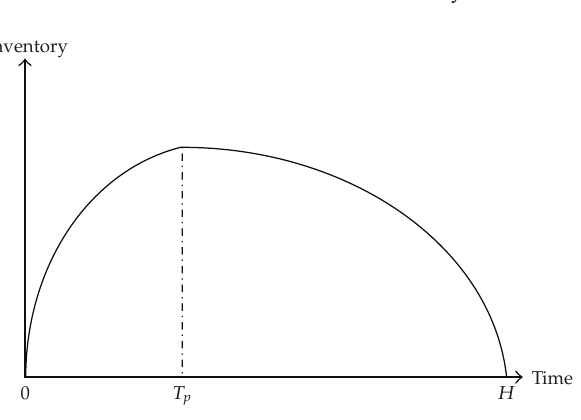
Figure 1: Inventory system without